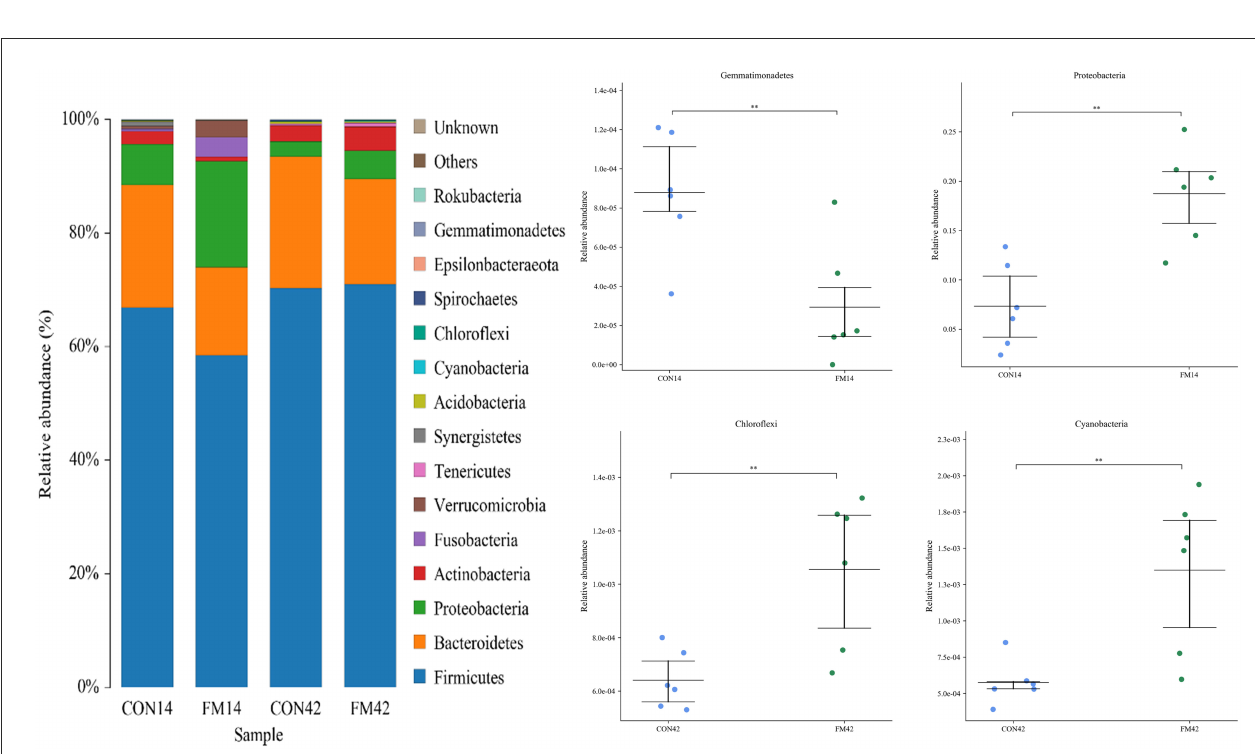
FIGURE6 Fecal microbiota richness and diversity at phylum level ( n = 6). The left side of the figure shows the composition of the bacteria, and the right side shows the bacteria with extremely significant differences at phylum level.